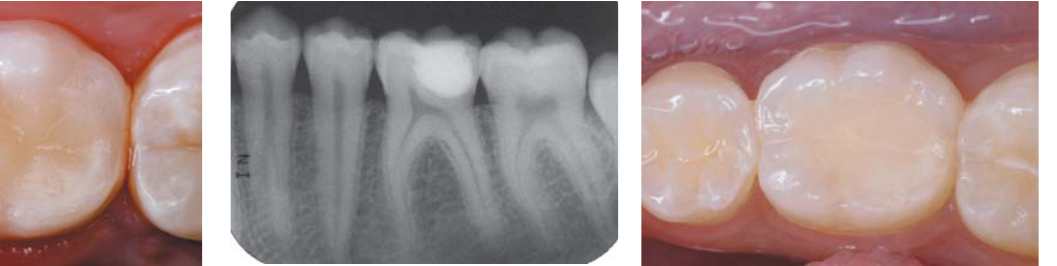
FIGURE 12- Occlusal view of the restoration after 4 years of follow-up